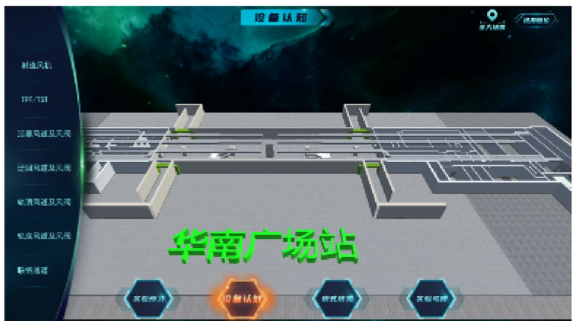
Figure 5. System equipment cognition